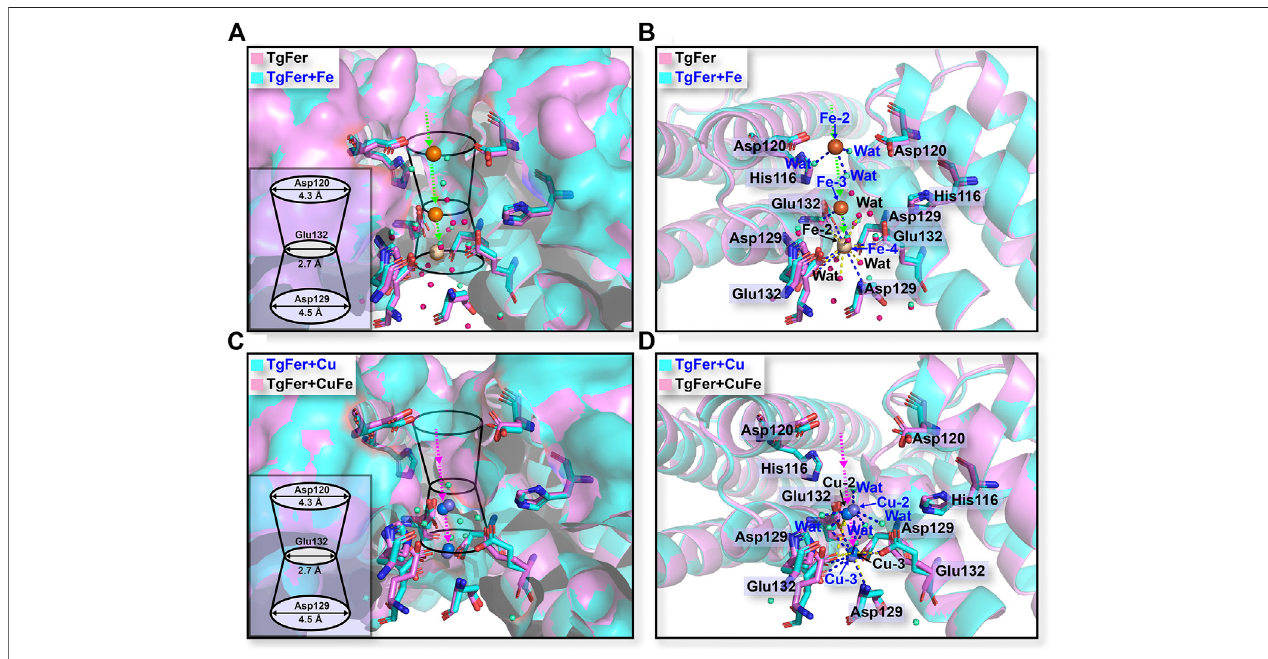
FIGURE 5 | (A) Stereo views of the 3-fold channels for TgFer and TgFer + Fe. (B) The detailed structure of the coordination environment for iron ions at the 3-fold channel in TgFer and TgFer + Fe (side view). Yellow spheres represent iron ions. (C) Stereo views of the 3-fold channels for TgFer + Cu and TgFer + CuFe. (D) The detailedstructure